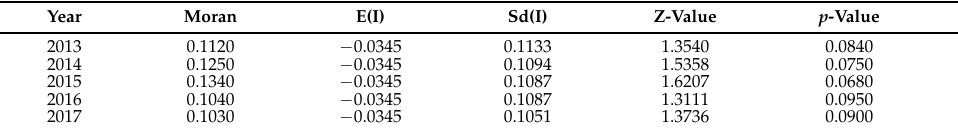
Table 4. Moran’s I index for the RLGILs of the 30 provinces.